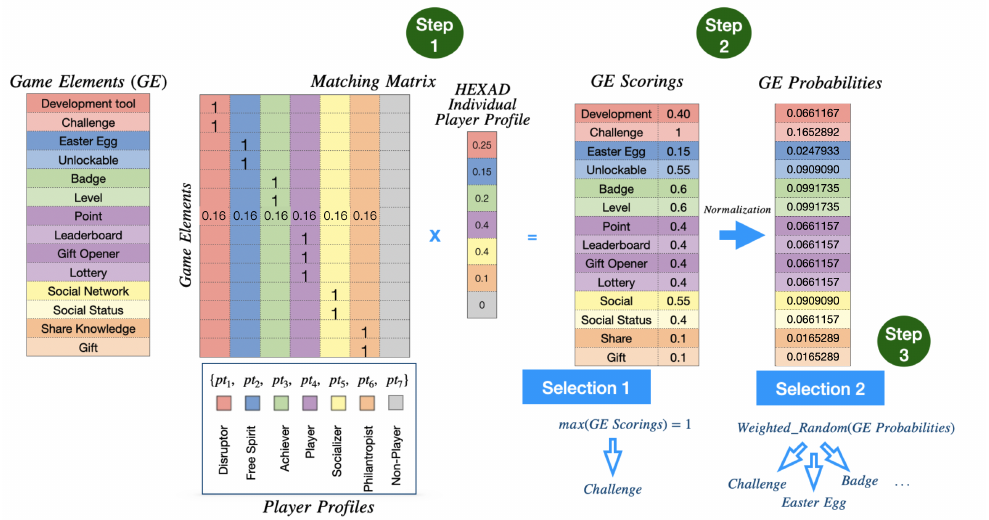
Figure 1. Overview of the StaticAG method, which involves three steps: Step 1 obtains the scorings of the game elements depending on an individual Player Profile vector and the Matching Matrix; in Step 2 we normalise these scorings; and finally, in Step 3, we select the Game Element. We also display two Selection methods: Selection1, Lavoué-based [15], obtains the top-scored Game Element, while Selection 2 obtains a weighted random Game element according to the probabilities computed in Step